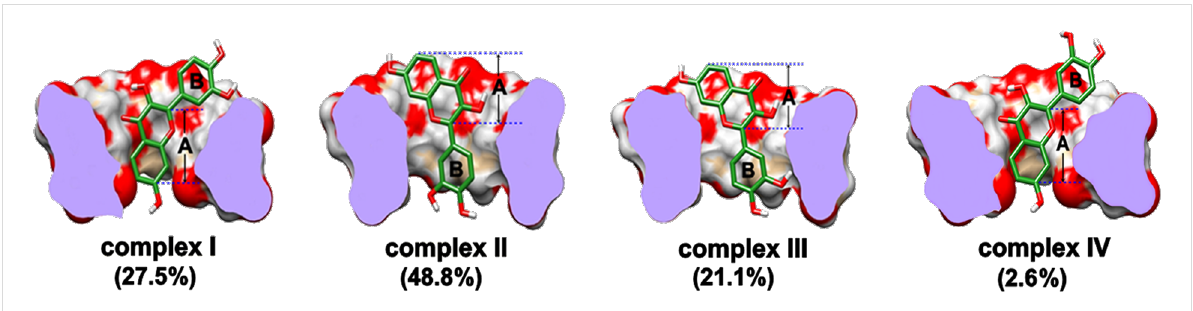
Figure 3: Docked structures of the four possible inclusion complexes between fisetin and β -CD, where their percentages of occurrence are given in parentheses.